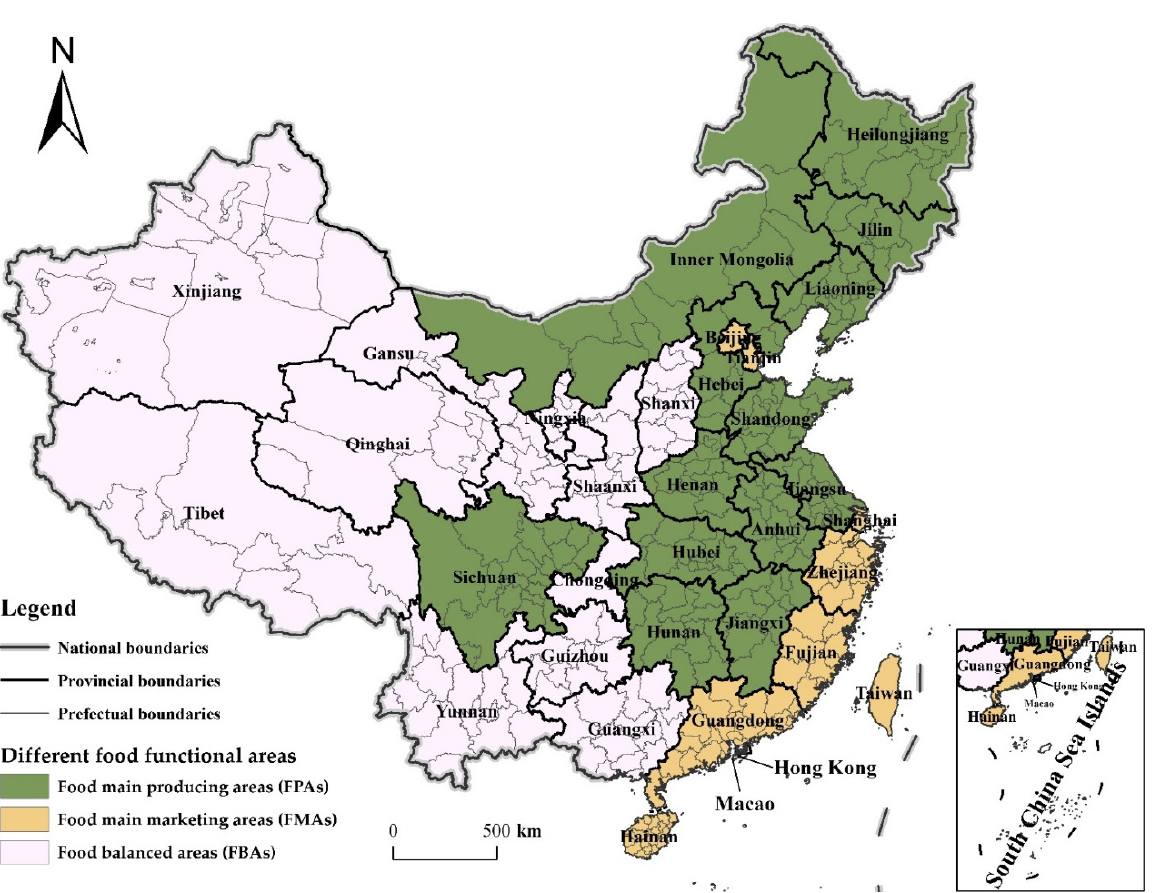
Figure 1. The distribution of different food functional areas. Note: This figure is drawn by the authors themselves based on ArcGIS.